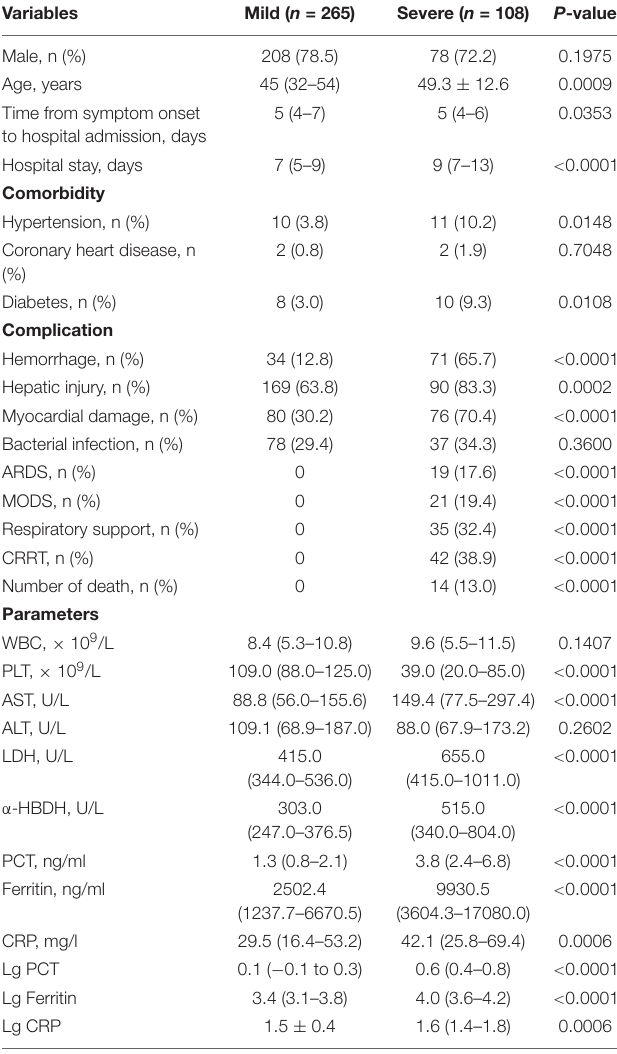
TABLE 2 | Demographics and clinical and laboratory data at admission in the patients with HFRS of different clinical types*.